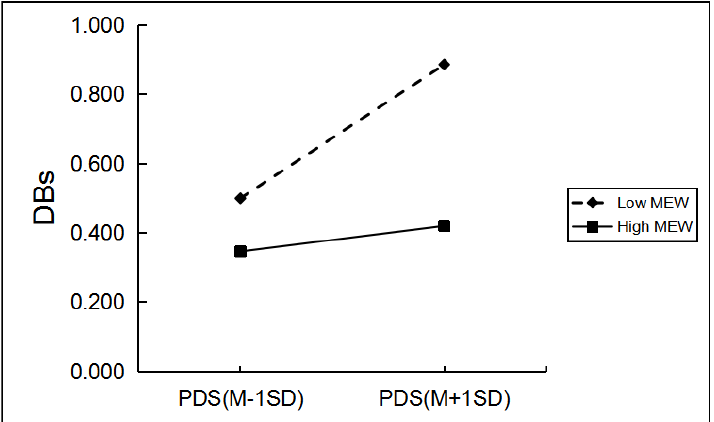
Figure 3. The two-way interaction between PT and MEW in predicting boys’ SBs. Note: PDS, the total score of pubertal development scale; MEW, mother emotional warmth; DBs, drinking behaviors.